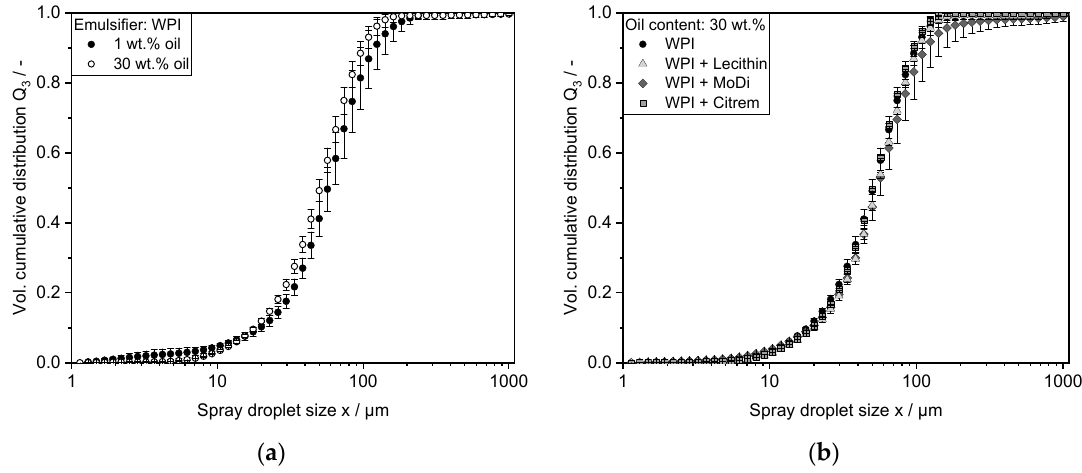
Figure A1. Spray droplet size distributions of: ( a ) emulsions stabilized with WPI with oil content of 1 wt.% and 30 wt.%; ( b ) emulsions with 30 wt.% oil content stabilized with WPI and WPI/LMWE.